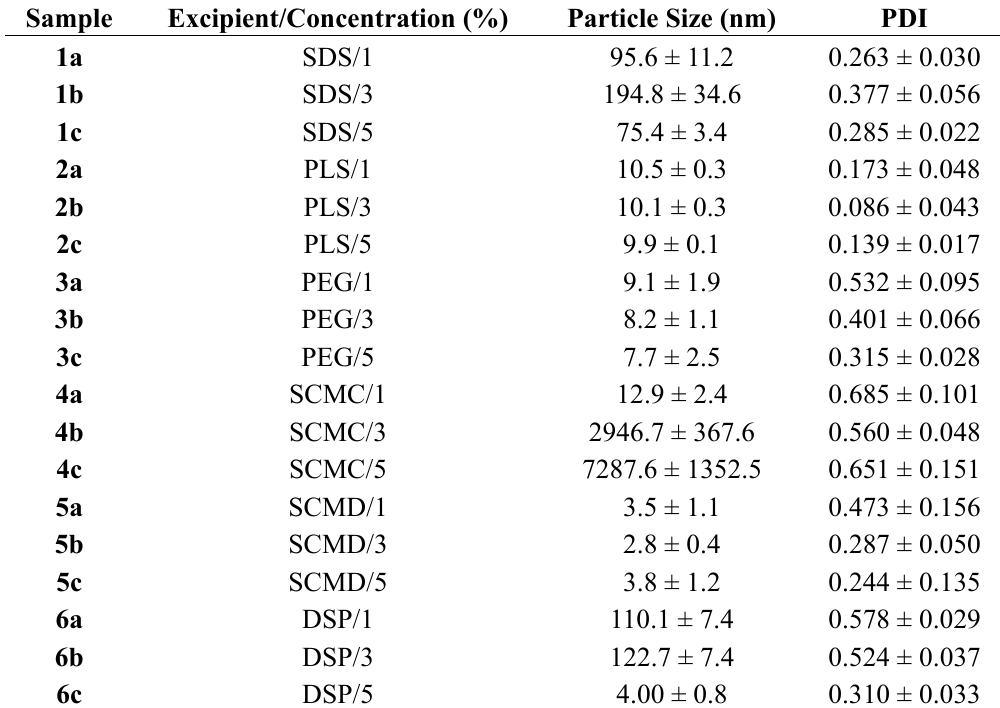
Table 1. Composition of samples, concentration (%) of individual excipients in water samples relative to risedronate, particle size (nm) and polydispersity index (PDI) of risedronate samples expressed as mean ± SD ( n = 5 independent measurements). (SDS = sodium dodecyl sulfate,